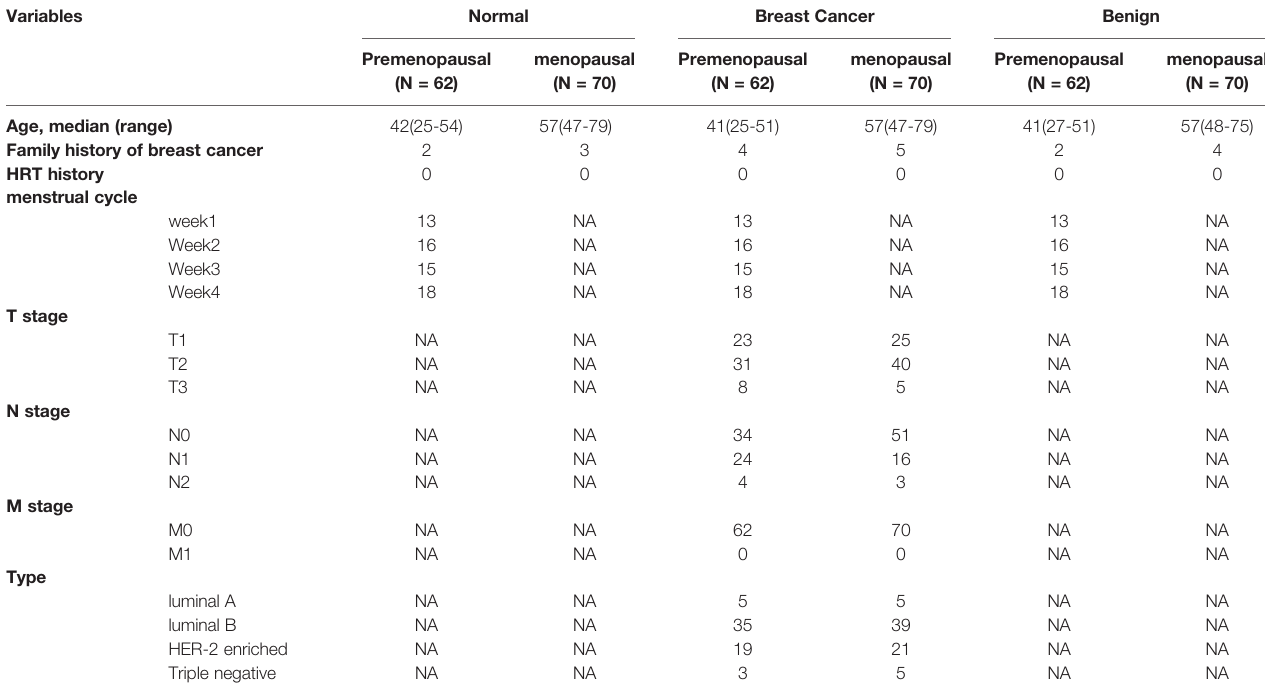
TABLE 1 | Clinicopathological characteristics of the patients in our study. Variables